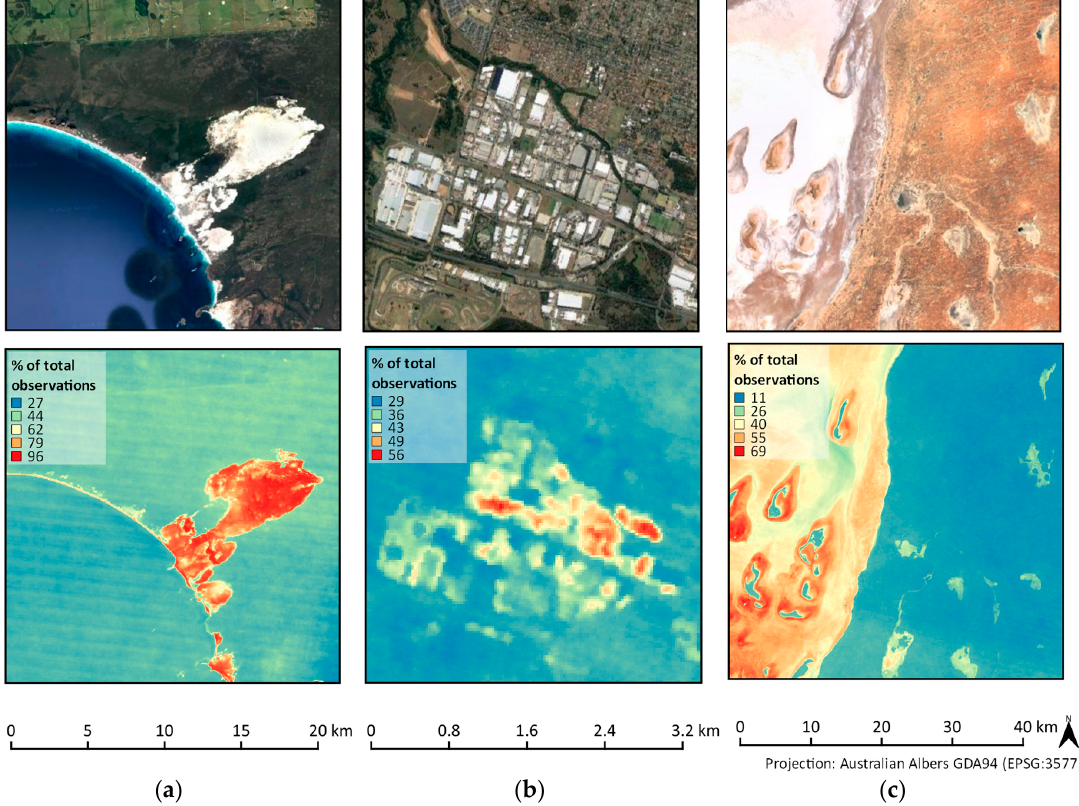
Figure 4. Fmask cloud flags (in percent of total observations) for coastal areas ( a —Cape Arid, WA), urban environments ( b —Ardnell Park/Huntingwood, NSW), and salt lakes ( c —Lake Frome, SA). High-resolution imagery: Google, CNES/Airbus, TerraMetrics, DigitalGlobe.